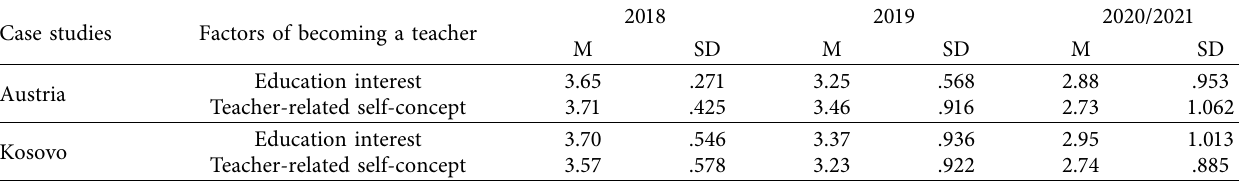
Table 4: Mean and standard deviation of two factors to become a teacher (3-year comparison).